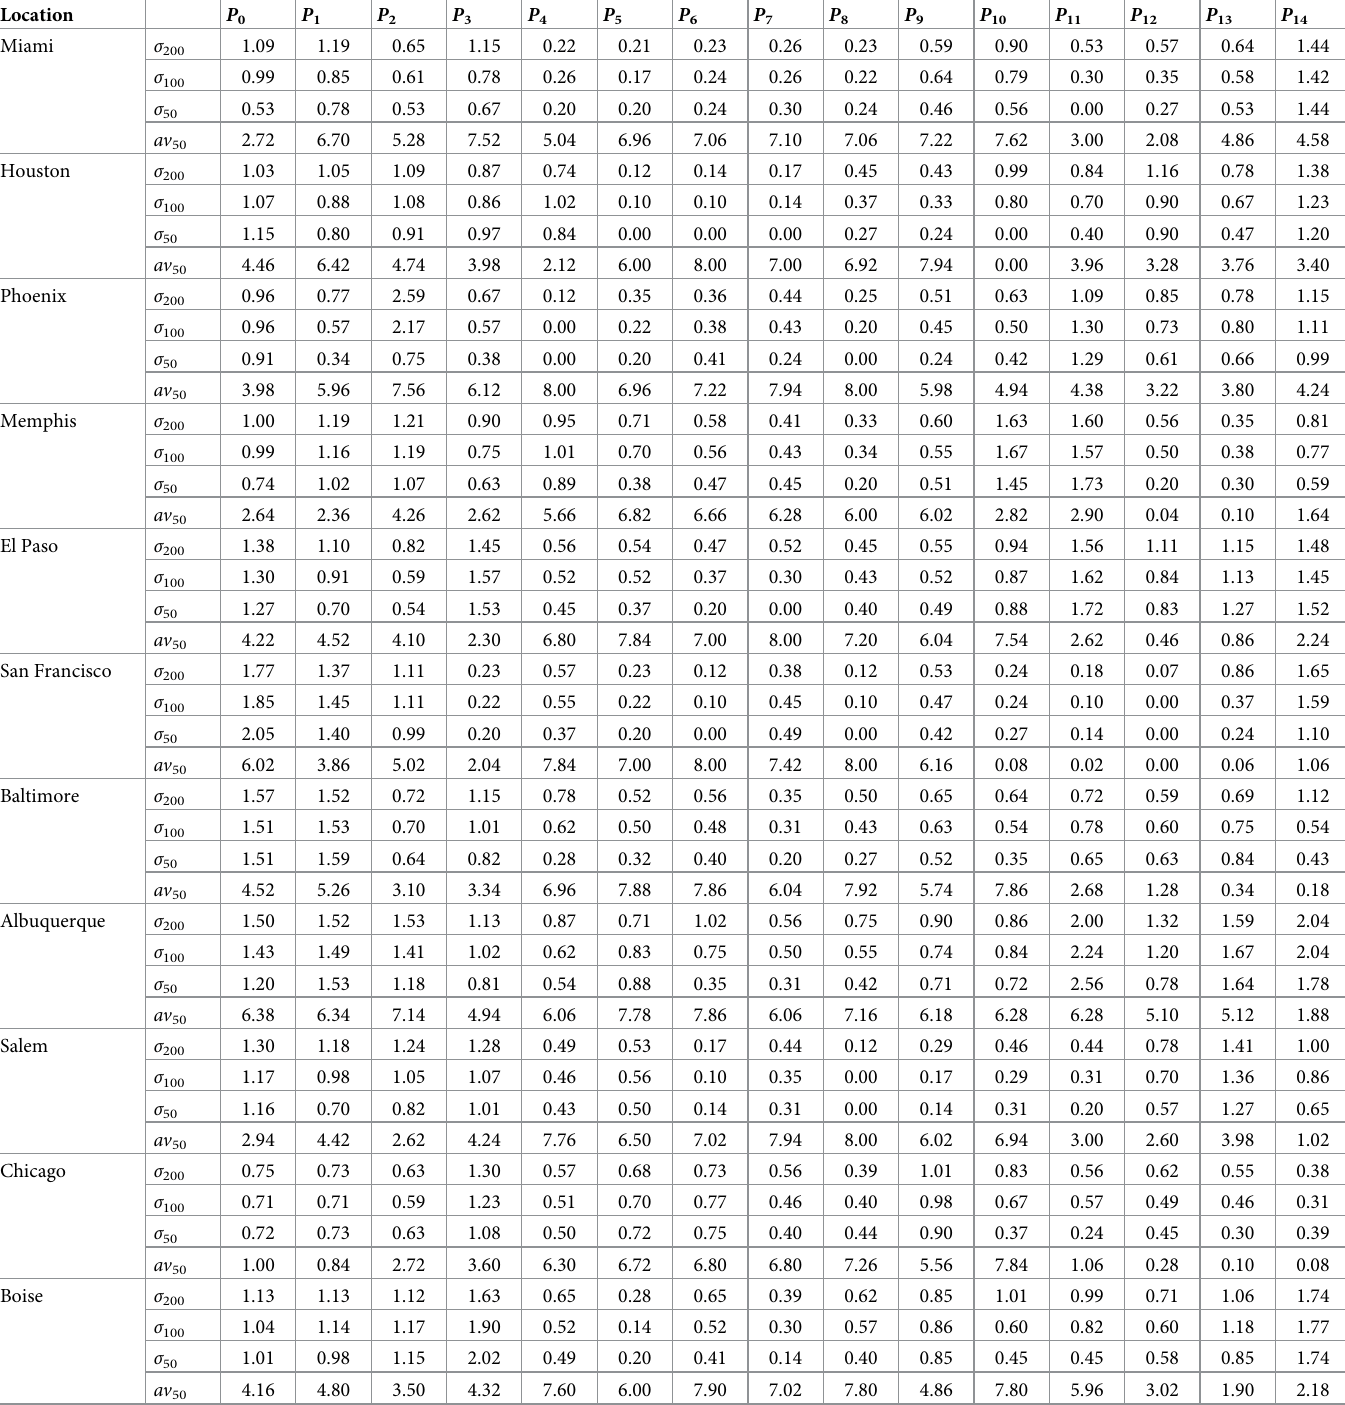
Table 2. Standard deviations of positions of control points in best shadings found by genetic optimisation for each model location.